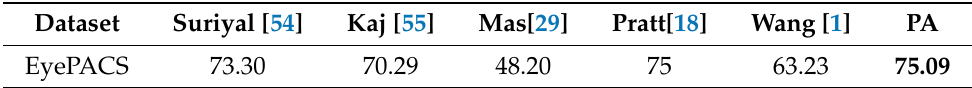
Table 6. Comparison of existing approaches with proposed approach (PA) in terms of % accuracy on dataset, namely EyePACS using 10-fold cross validation.